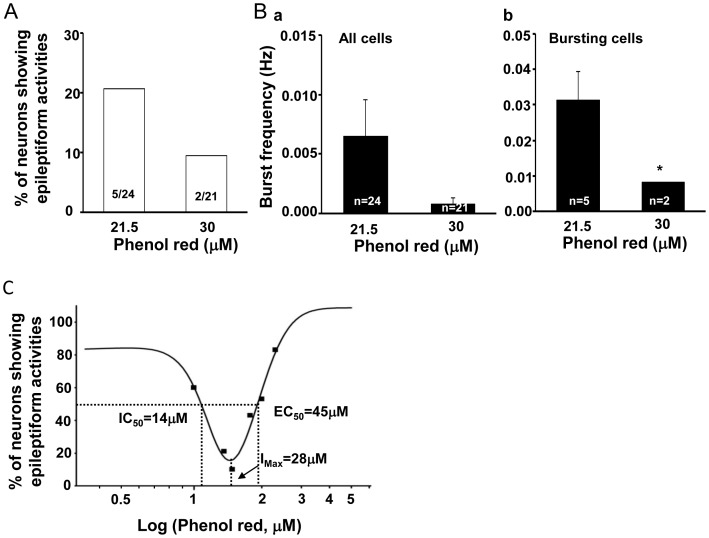
Effect of phenol red concentration at 21.5 µM and 30 µM in the burst activities in the cultured hippocampal pyramidal neurons.A–B. Bar histograms showing stronger suppressive effect of phenol red at 30 µM on the epileptiform bursting activities than at the commercially available medium with the added concentration of phenol red (21.5 µM). C. Curve of the two phase effect of phenol red on the epileptiform bursting activities with the inhibitory phase at the low concentration (IC50 = 14 µM) and the enhancing phase at the high concentration (EC50 = 45 µM); with the most effective concentration for the burst suppression seen at 28 µM. * P<0.05.